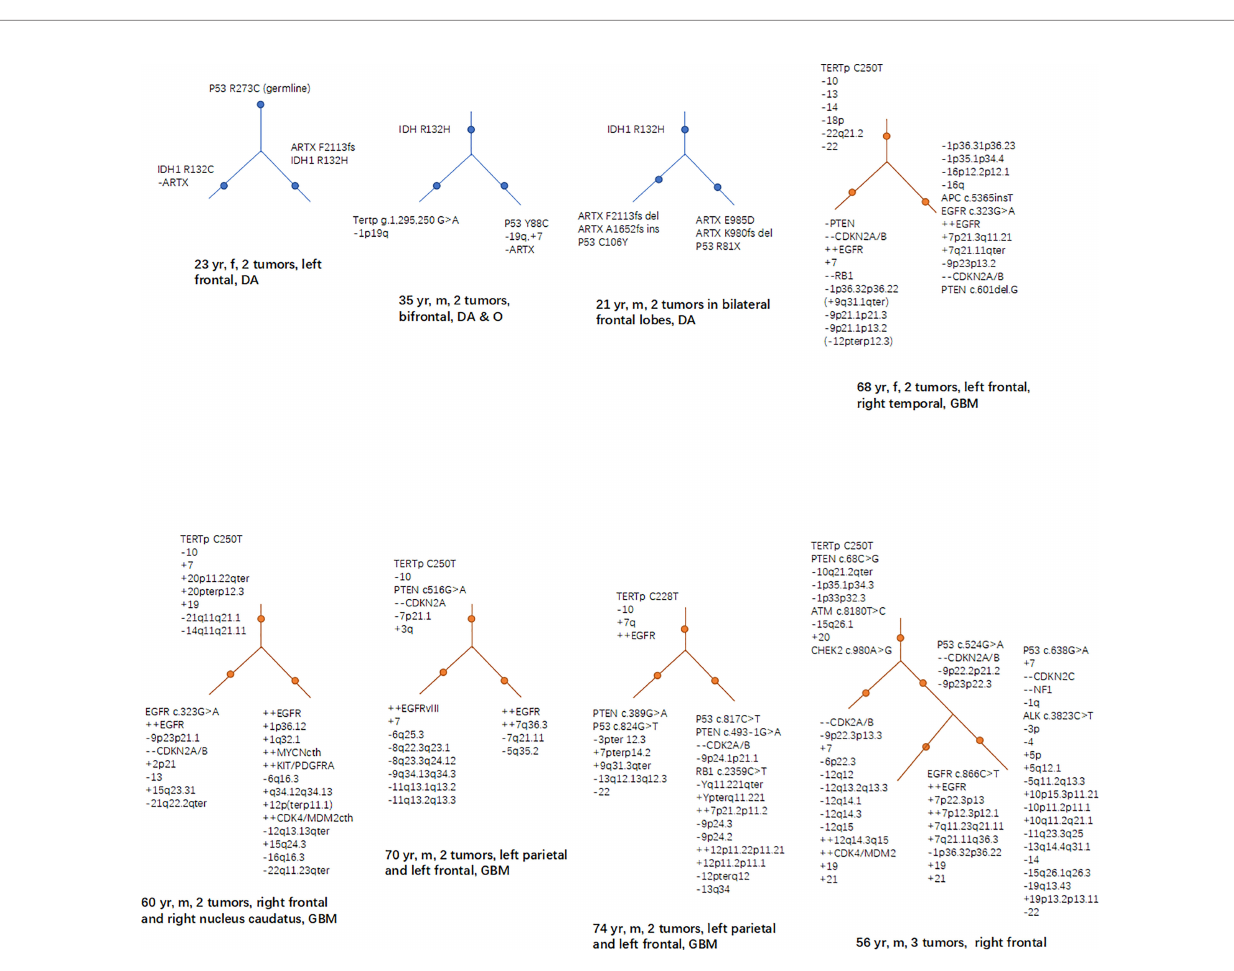
FIGURE 2 | Hierarchical structures of the mutations revealed by studies based on MCG cases. In low grade glioma (including diffuse astrocytoma and oligodendroglioma), mutations of IDH, TP53 and ARTX frequently lies in the higher levels of the hierarchy; while in GB, TERTp, PTEN loss, EGFR, and CDKN2A are more frequently seen in the higher levels of the mutational